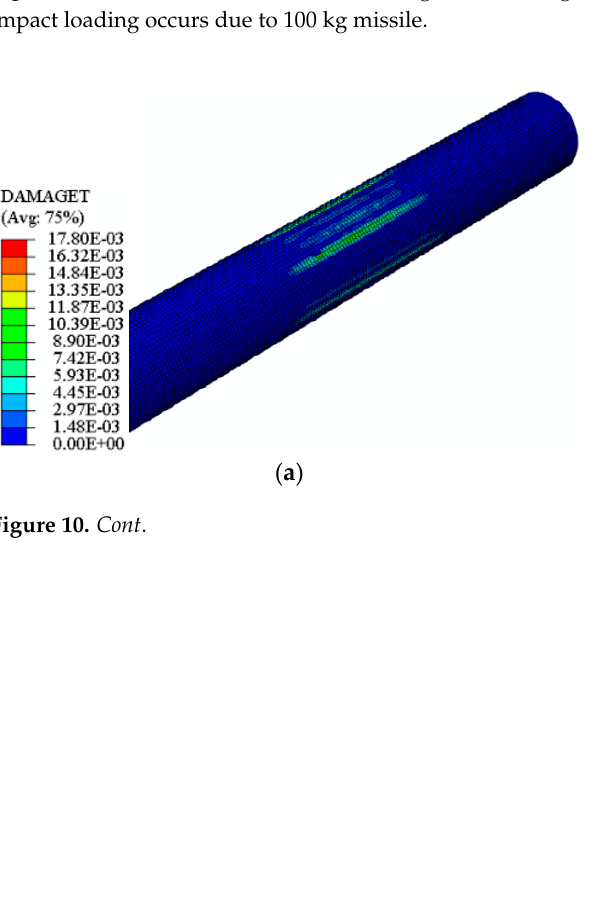
Figure 9. Deformation contours of ( a ) Jhingurda, ( b ) Singrauli, ( c ) Jamrani and ( d ) Kota when an impact loading occurs due to 100 kg missile.